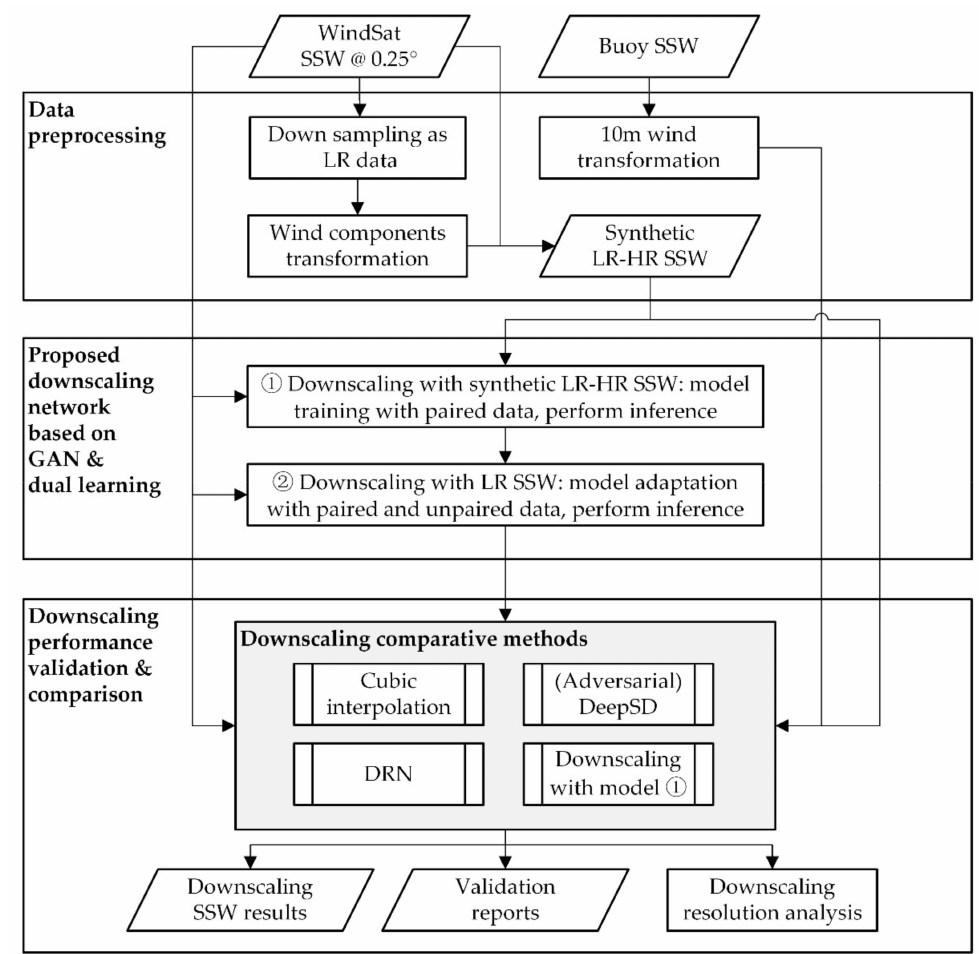
Figure 3. The method flowchart of sea surface wind downscaling in this